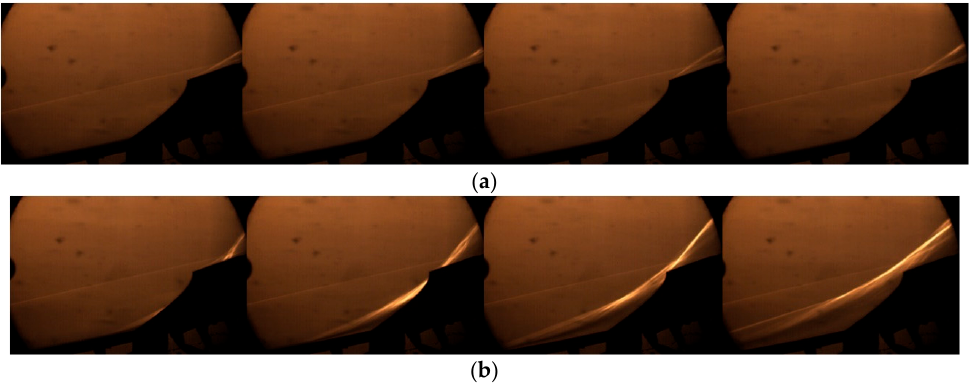
Figure 7. Schlieren images of ‘little buzz’ and ‘big buzz’(( a ) ‘little buzz’; ( b ) ‘big buzz’).